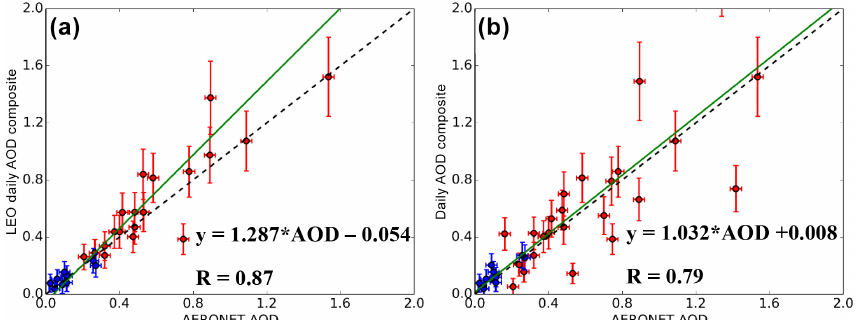
Figure 10. (a) Daily average of Level 1.5 AERONET 550nm AOD retrievals vs. the daily AOD composite including only LEO satellite retrievals for the 6-day period from 18 to 23 March 2014 (Table 4). (b) Same as (a) except daily average of AERONET AOD retrievals vs. our daily AOD composite product (GEO and LEO retrievals). AERONET AOD data from 15 different sites across East Asia (red) and five different sites across the western United States (blue) were used to validate the daily AOD composites. Error bars are based on ± 0.015 uncertainty for AERONET AOD retrievals, ± 0.05 ± 0.15 × AOD for LEO retrievals, and 25% uncertainty for our daily AOD composite product. The 25% uncertainty is the average of the GEO uncertainty range (18–34%). The linear regression lines are in solid green, with corresponding equations and correlation coefficients in the lower right